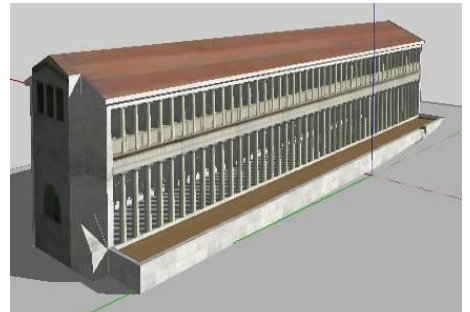
Figure 9: Stoa of Attalos